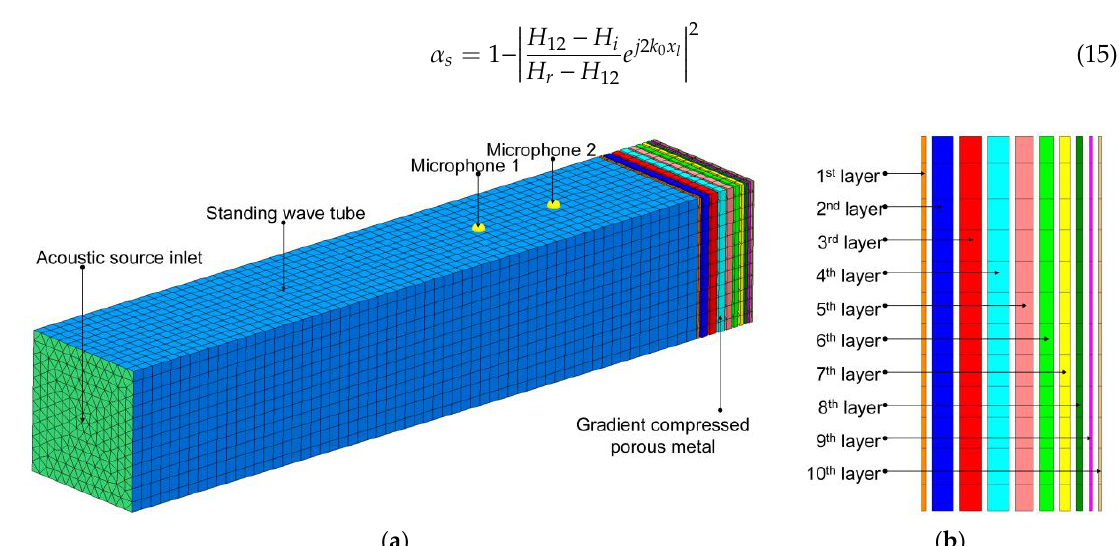
Figure 2. The constructed finite element simulation model for 10-layer gradient compressed porous metal. ( a ) Frame diagram of the system of the standing wave tube measurement; ( b ) schematic drawing compositions of the 10-layer gradient compressed porous metal.